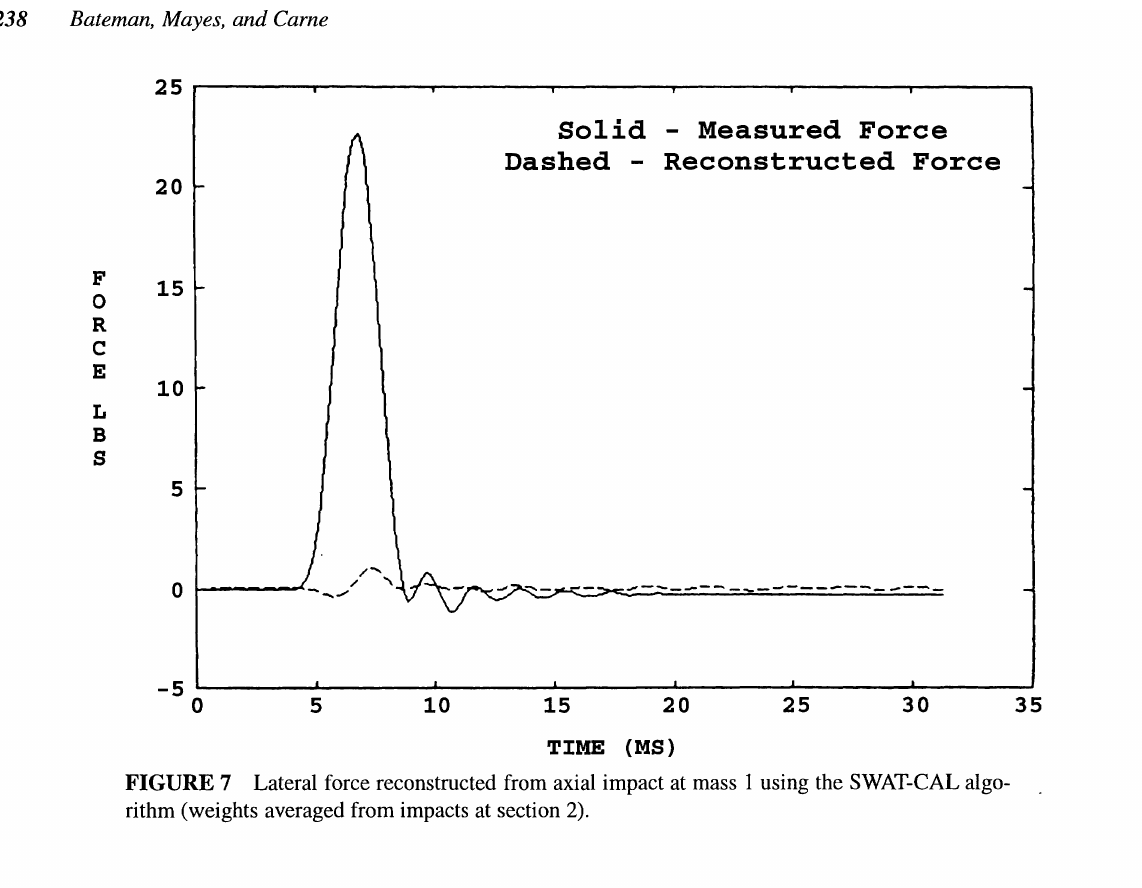
FIGURE 7 Lateral force reconstructed from axial impact at mass 1 using the SWAT-CAL algo rithm (weights averaged from impacts at section